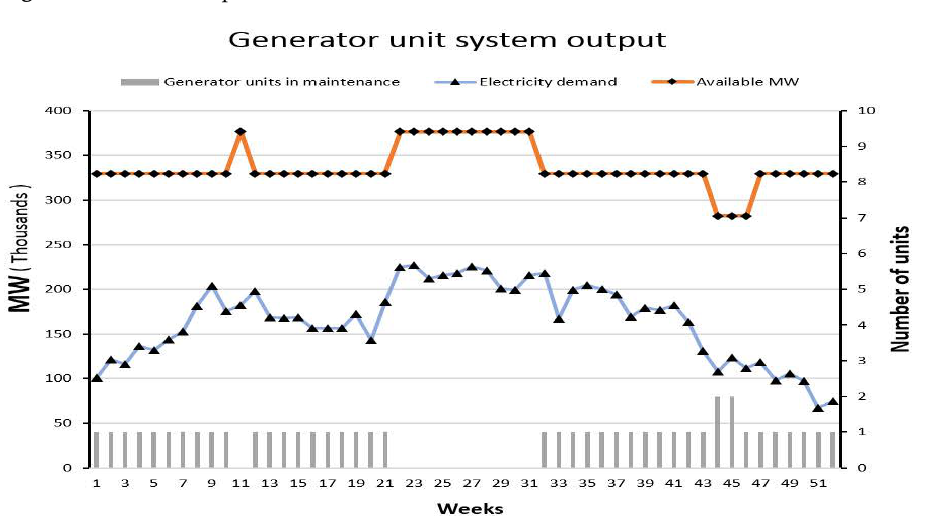
Figure 4. MEW water production versus demand.